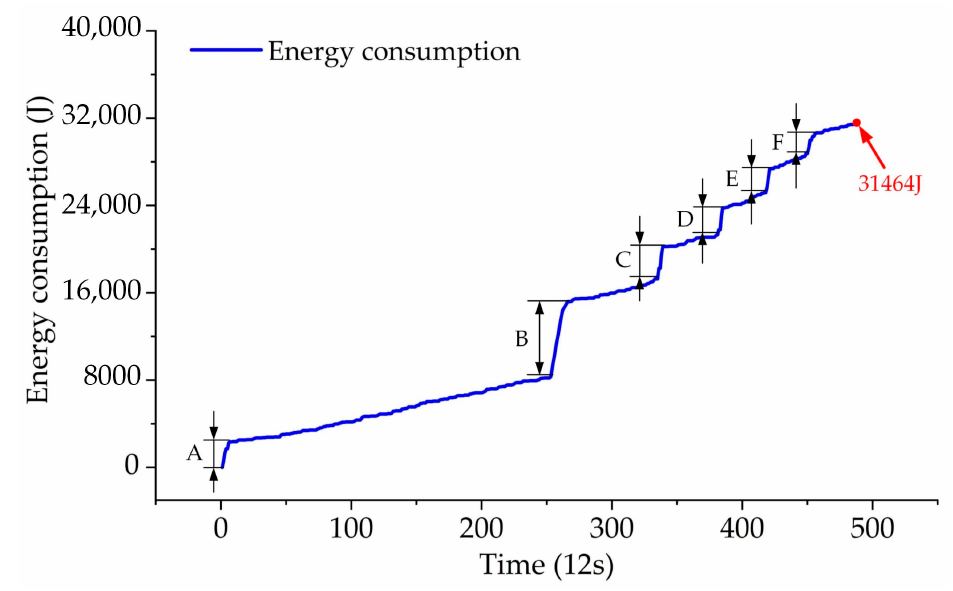
Figure 18. The energy consumption curve of the profile.